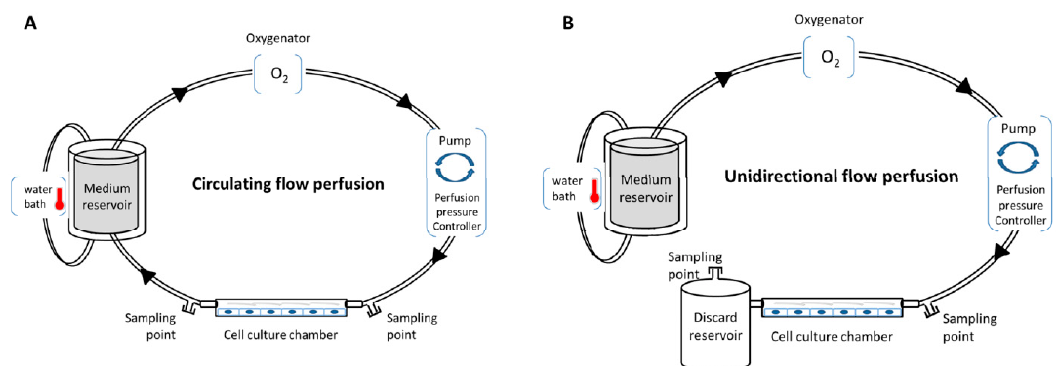
Figure 1. Conventional in vitro perfusion models. ( A ) Circulating flow perfusion design with closed circulation; ( B ) unidirectional flow perfusion design without recirculation.